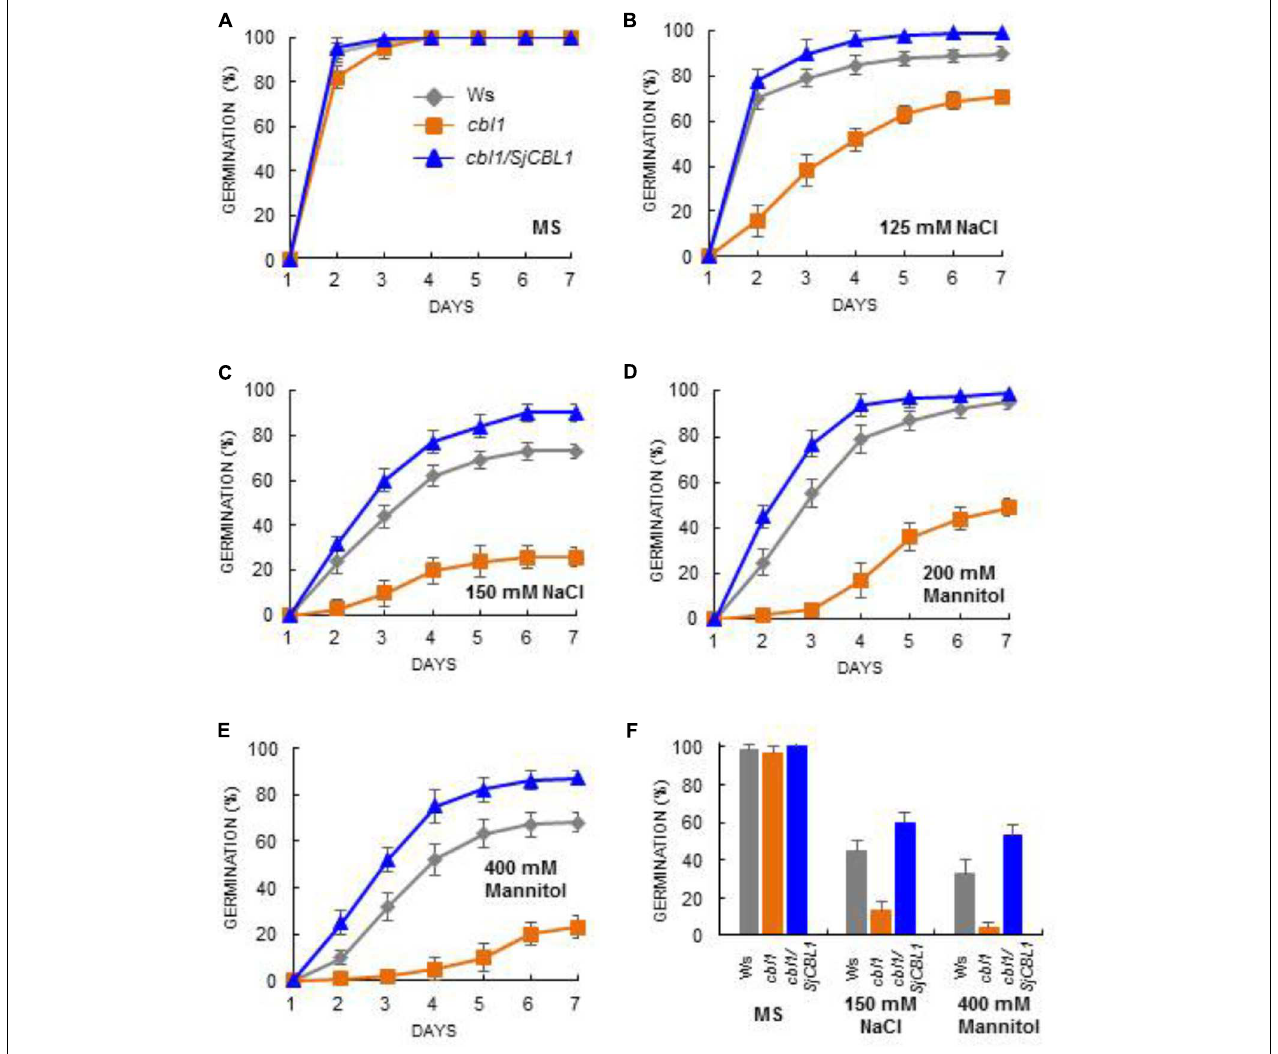
FIGURE 11 | Seed germination analysis. Arabidopsis seeds of wild-type (Ws), cbl1 mutant, and cbl1 /SjCBL1 complementation plants were plated on MS agar medium (A) and MS medium supplemented with 125 mM NaCl (B) , 150 mM NaCl (C) , 200 mM Mannitol (D) , or 400 mM Mannitol (E) . The plates were incubated at 4 ◦ C for 3 days before transfer to 23 ◦ C for germination. Germination time course (days of incubation at 23 ◦ C) was recorded for Ws (rhombuses), cbl1 (squares), and cbl1 /SjCBL1 plant (triangles) seeds. (F) Seed germination rates in Ws, cbl1 , and cbl1/SjCBL1 on MS medium (control) or MS medium containing 150 mM NaCl or 400 mM mannitol. Germination was scored at 3 days after incubation at 23 ◦ C. Results are presented as average values ± SE from three independent